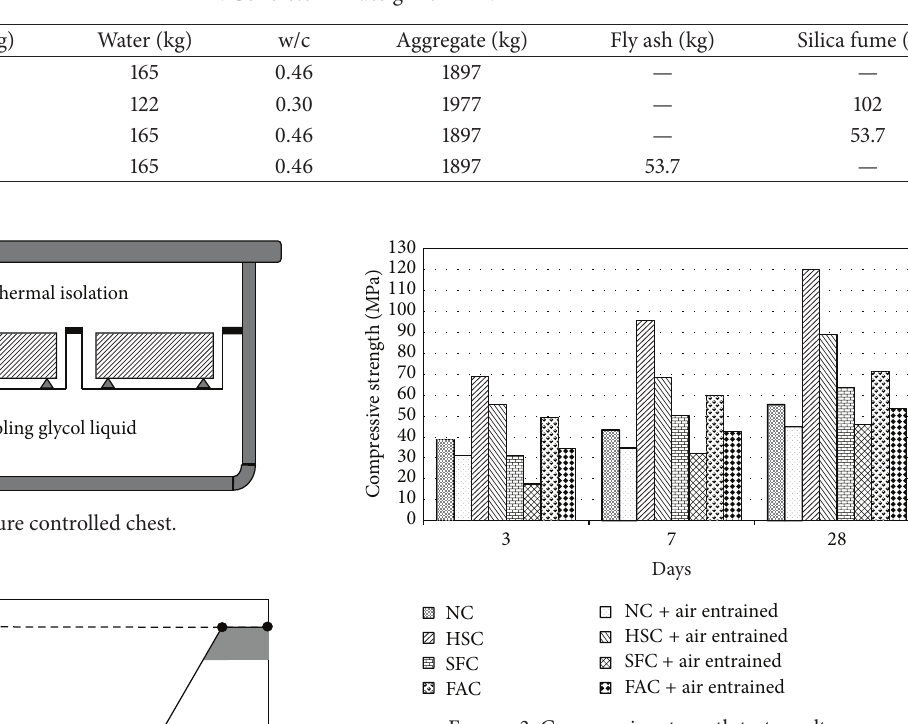
Figure 3: Compressive strength test